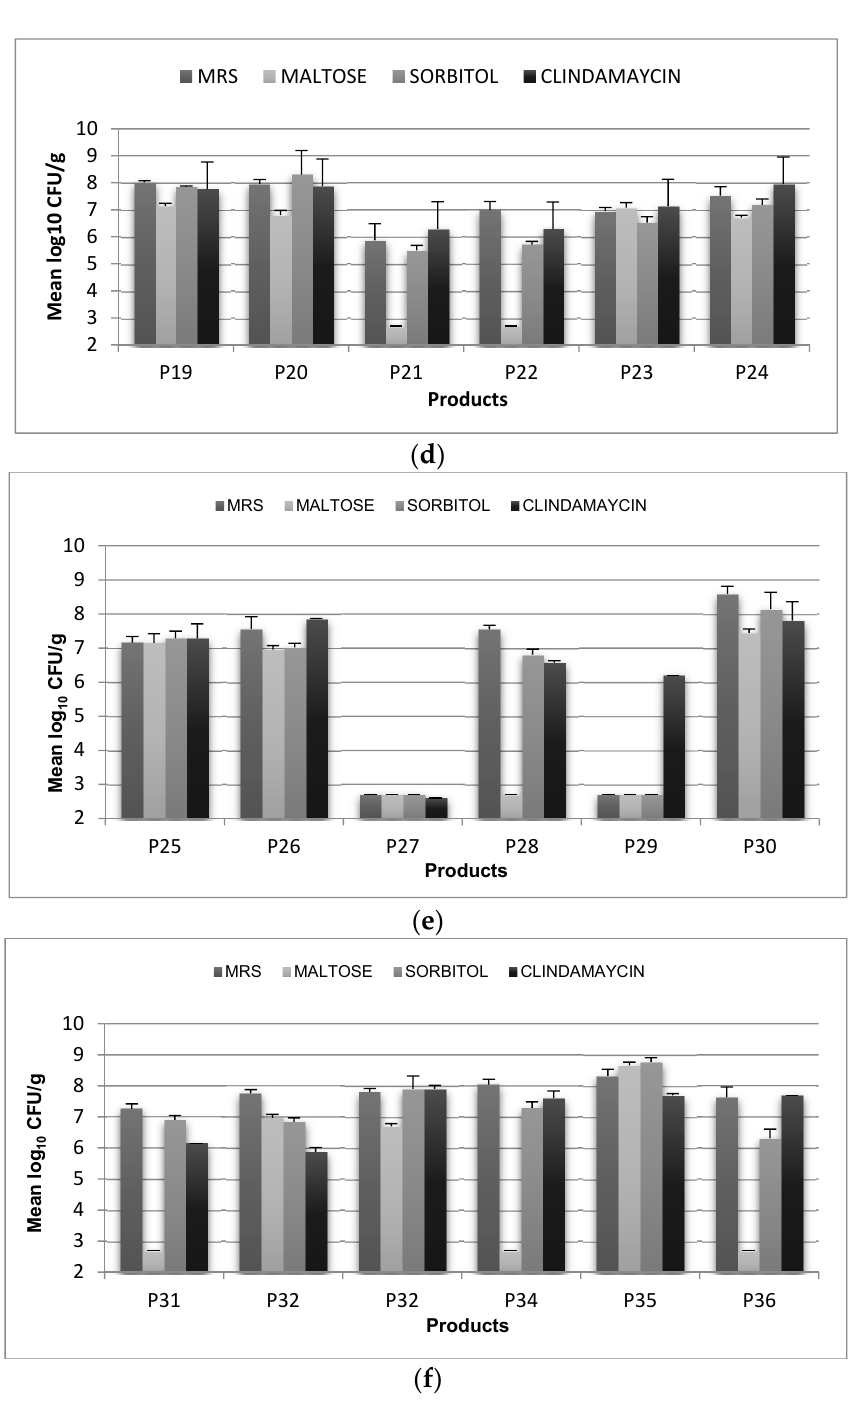
Figure 1. Bacterial count of presumptive lactobacillus spp. strains (log 10 CFU/g) on (MRS, MRS Maltose, MRS-Sorbitol, MRS-Clindamaycin) at 37 °C after 48 h anaerobic incubation. Data are means ± SD (n = 4). P1-P36 are sample codes for tested probiotic products.